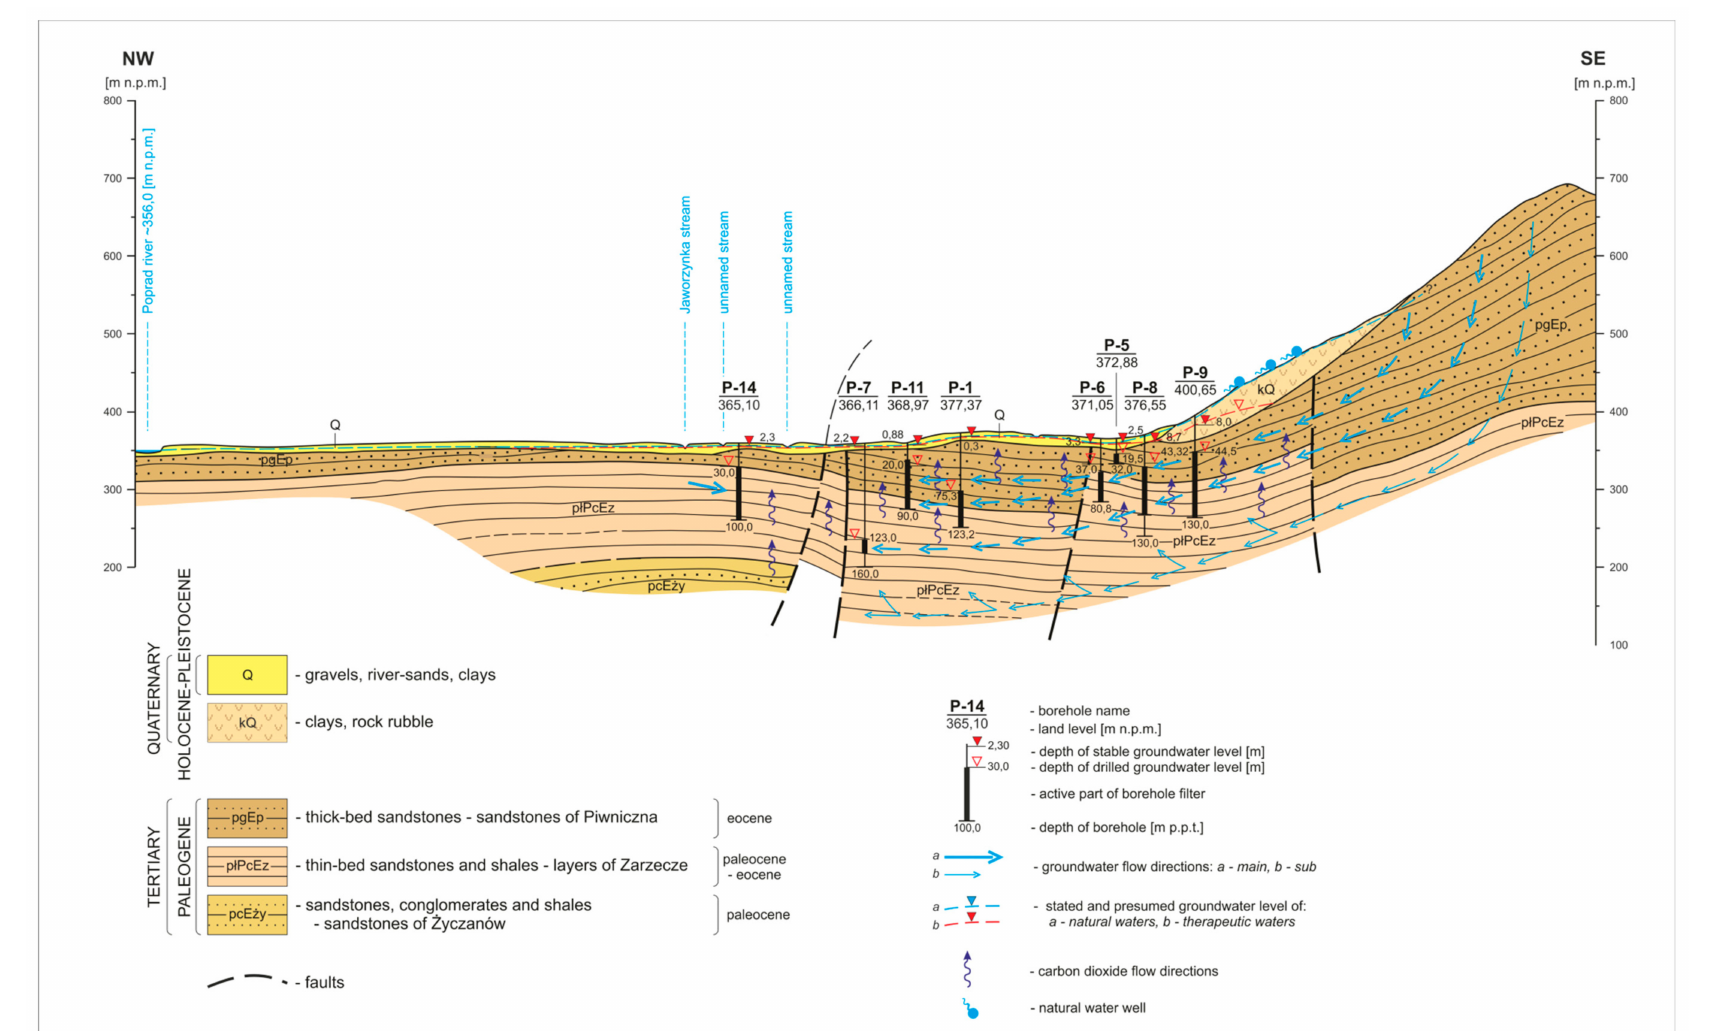
Figure 1. Hydrogeological cross-section with CO 2 directions [29–31] modified (cross-section line is shown on Figure